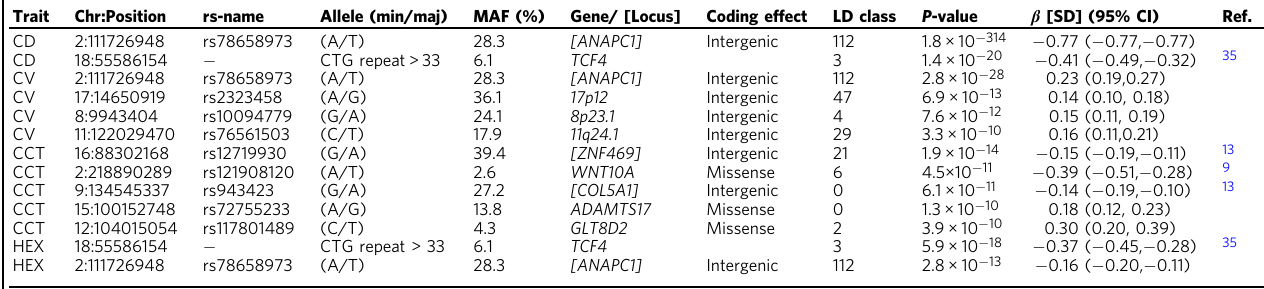
Table 2 Association results Trait